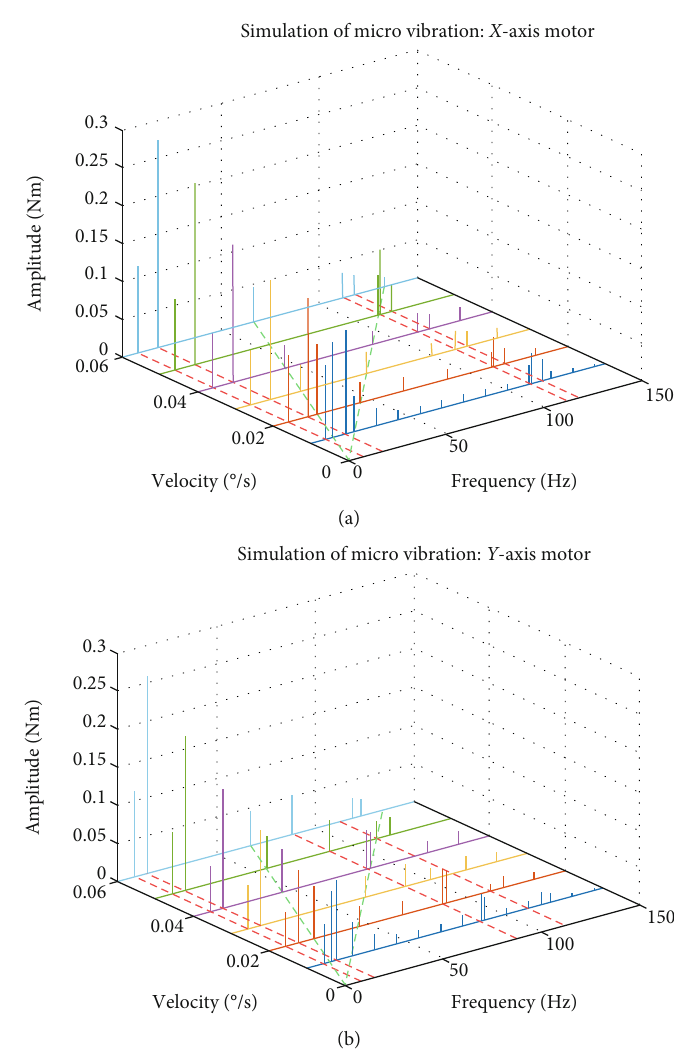
Figure 5: Simulation results of microvibration of the antenna at di ff erent velocity: (a) x -axis motor; (b) y -axis